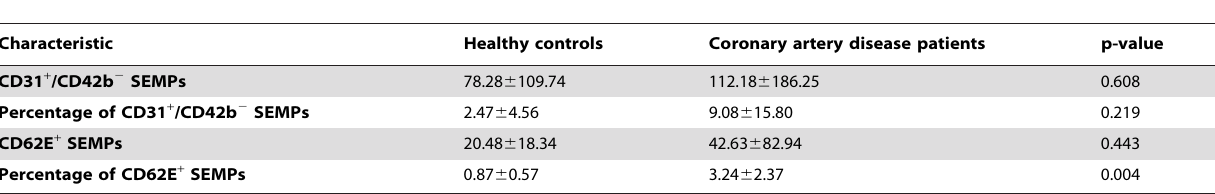
Table 1. Characters of SMPs in healthy subjects and coronary artery disease patients.